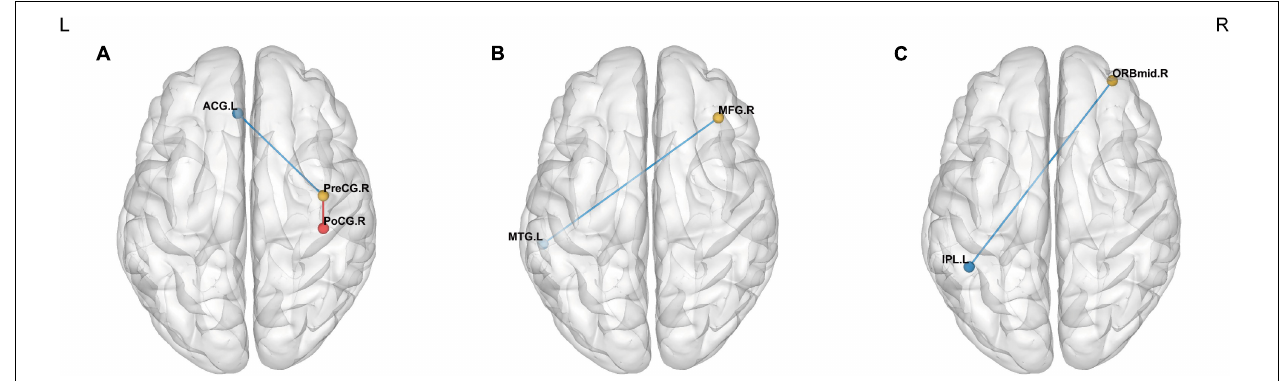
FIGURE 4 | Intergroup comparison of FC between the CAI patients and HCs. The blue lines: decreased FC; the red line: increased FC. Compared with the HCs, the CAI group showed (A) decreased FC between the right precentral gyrus and the left ACC and increased FC between the right precentral gyrus and the right postcentral gyrus. (B) Decreased FC between the right middle frontal gyrus and left middle temporal gyrus. (C) Decreased FC between the OFC and the left IPL. ACG.L, the left anterior cingulate gyrus; PreCG.R, the right precentral gyrus; PoCG.R, the right postcentral gyrus; MFG.R, the right middle frontal gyrus; MTG.L, the left middle temporal gyrus; ORBmid.R, the orbital part of the right middle frontal gyrus; IPL.L, the left inferior parietal lobule.